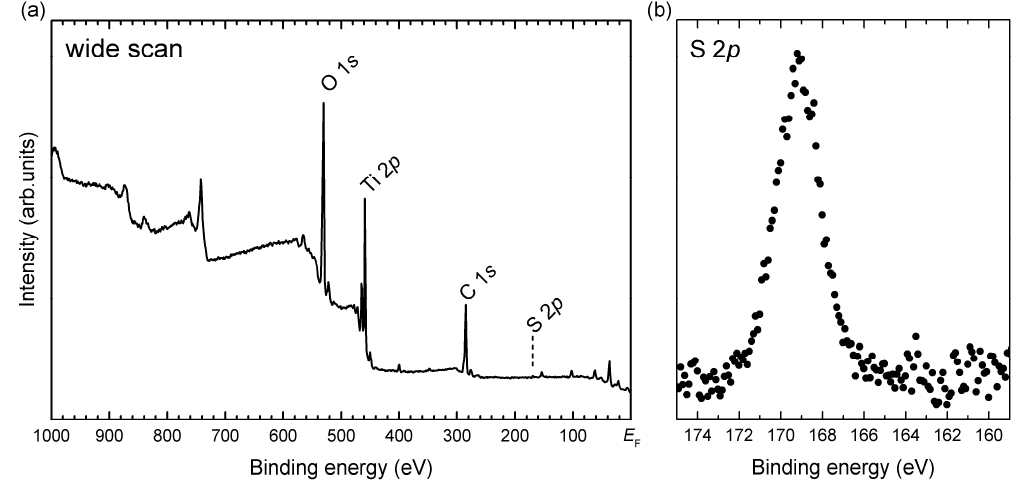
Figure 5. ( a ) XPS wide scan from the sample. The main features of the sample are highlighted in the image. The S peak (not visible on this spectrum) is marked with a dashed line. ( b ) S 2p peak showing a binding energy (BE) of 169.2 eV (see the text for more details).